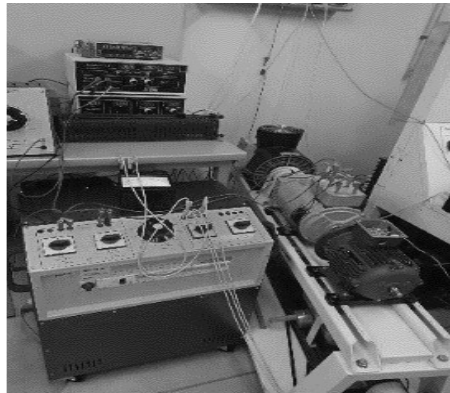
Figure 8. Experimental setup for motor testing.